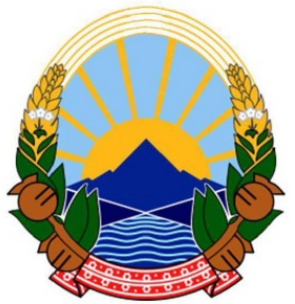
Figure 5. Coat of arms of the Republic of Macedonia adopted in 2009 after the removal of the red star.